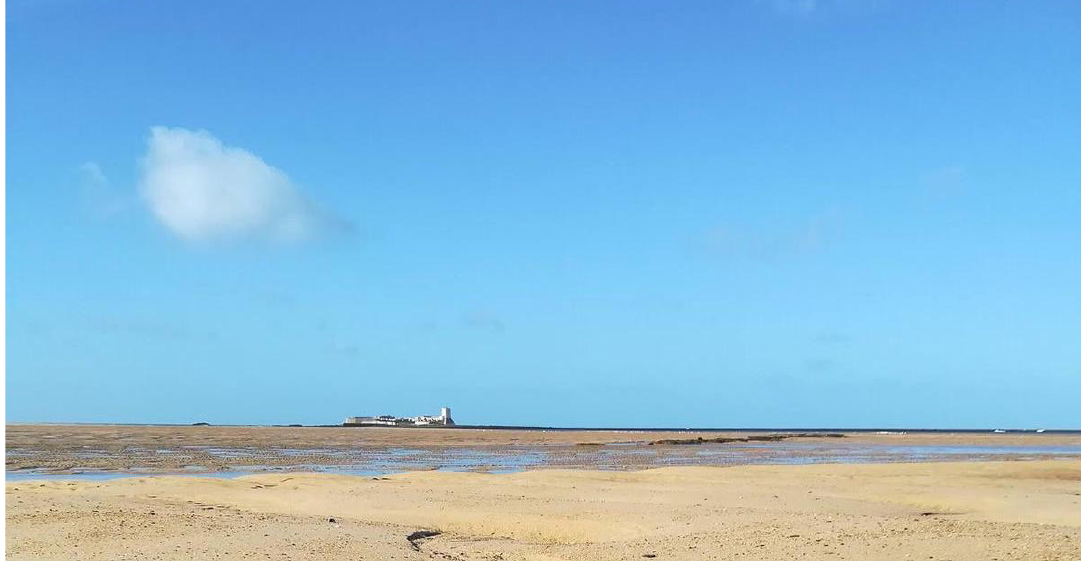
Figure 6. View of the Sancti Petri Castle from the Punta del Boqueron at low tide. ©Castillo Sancti